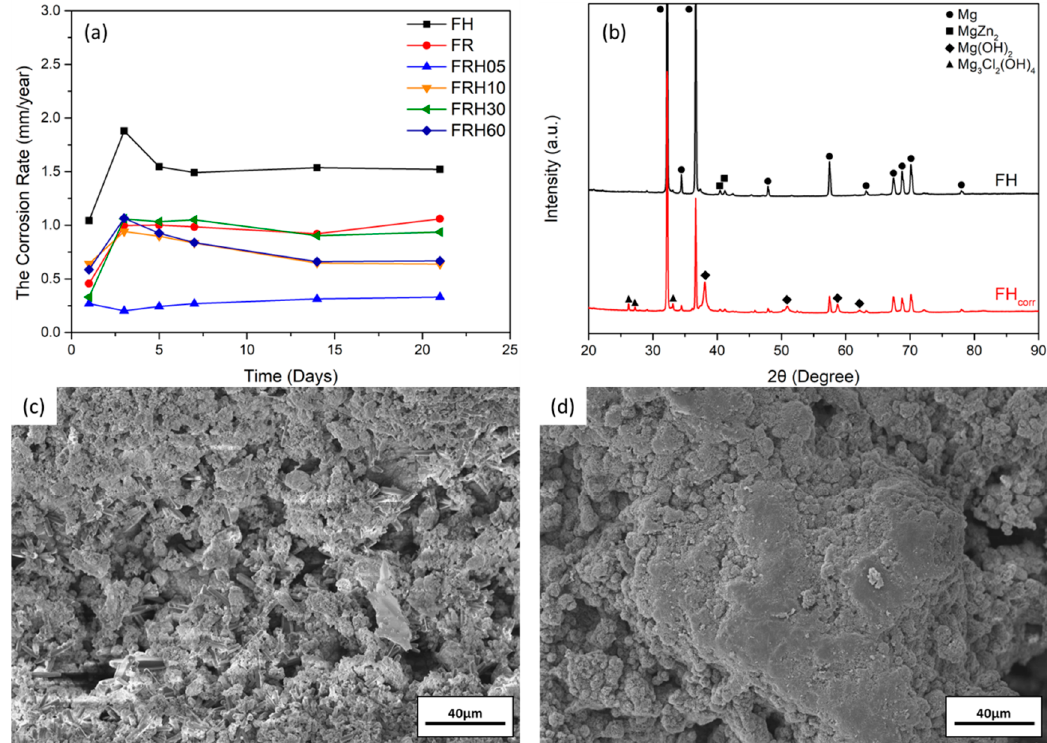
Figure 8. Immersion testing result: ( a ) Corrosion rate of ZKX500 specimens, ( b ) XRD patterns before and after immersion testing, ( c ) FH corroded surface after immersion, and ( d ) FRH30 after immersion.